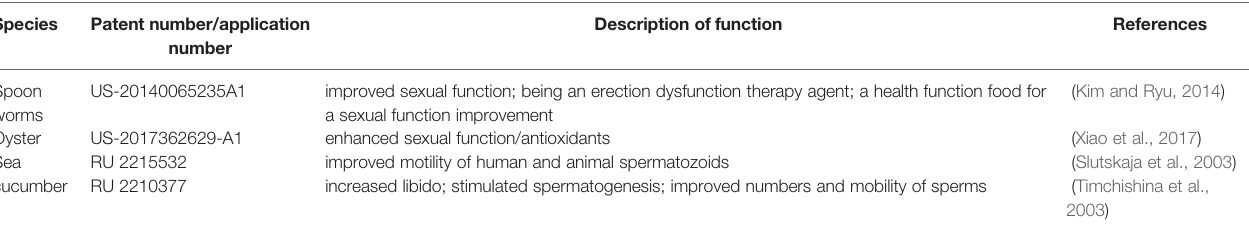
TABLE 2 | A summary of patents on marine animals to support human reproductive